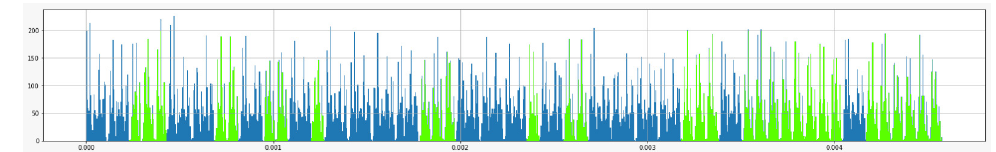
Figure 4: Results from glitching RSA, with individual key bits color-coded according to the operation (and thus the value of the key